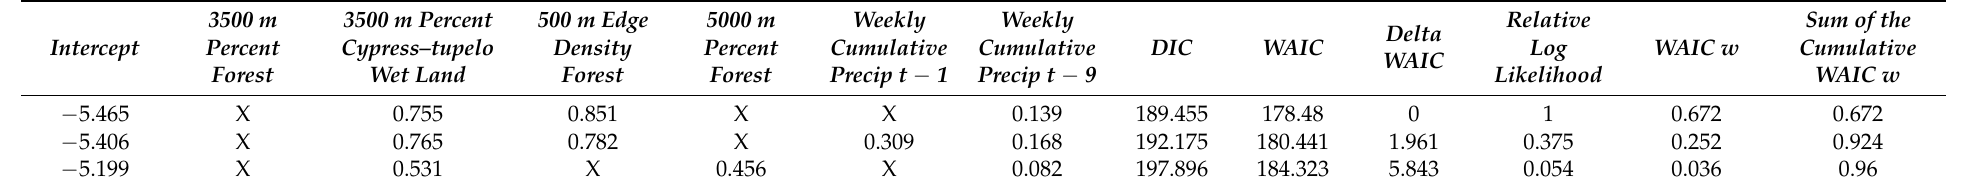
Table 1. The 95% confidence set of models for EEEV based on the cumulative sum of the WAIC weights. An “X” present in a column cell indicates that the corresponding variable was not included in the model.